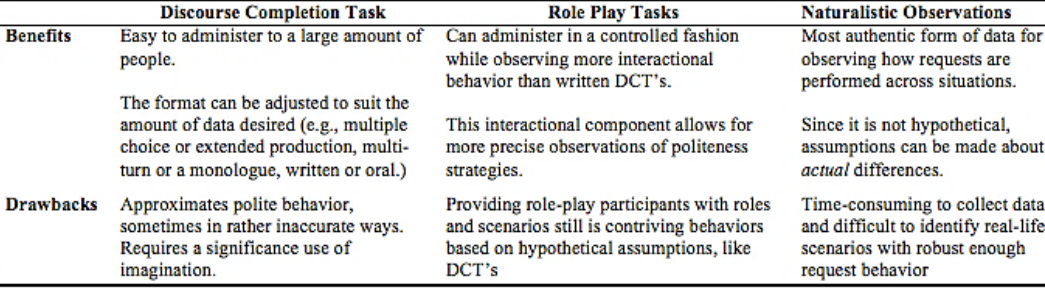
Overview of Data Collection Methods for observing request behavior Adapted from Sasaki